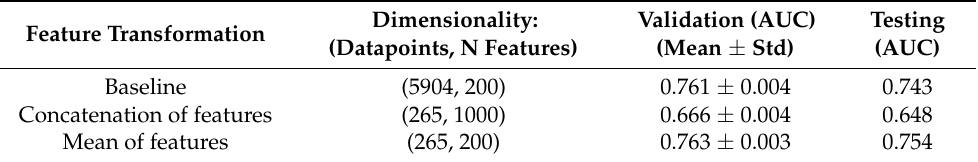
Table 7. The performance with the decision-level aggregation of information. Patient Combination